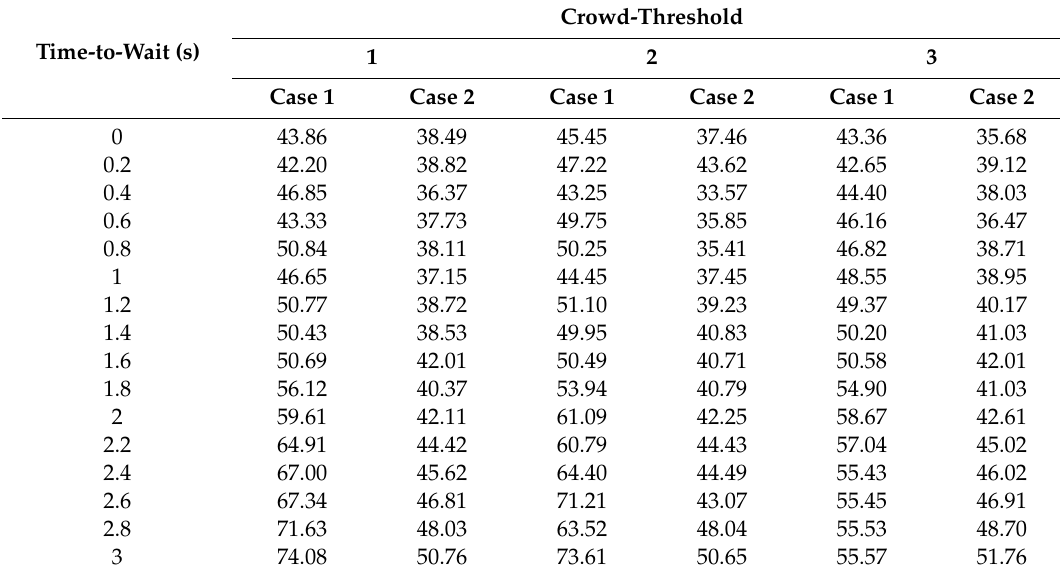
Table 2. E ff ects of time-to-wait and crowd-threshold parameters on reconsideration performance.